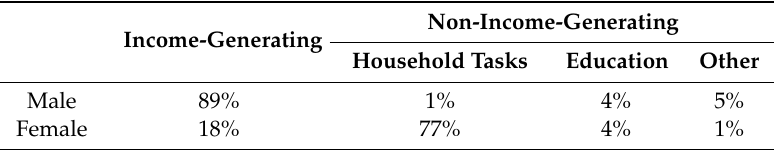
Table 3. Distribution of main activity by gender.